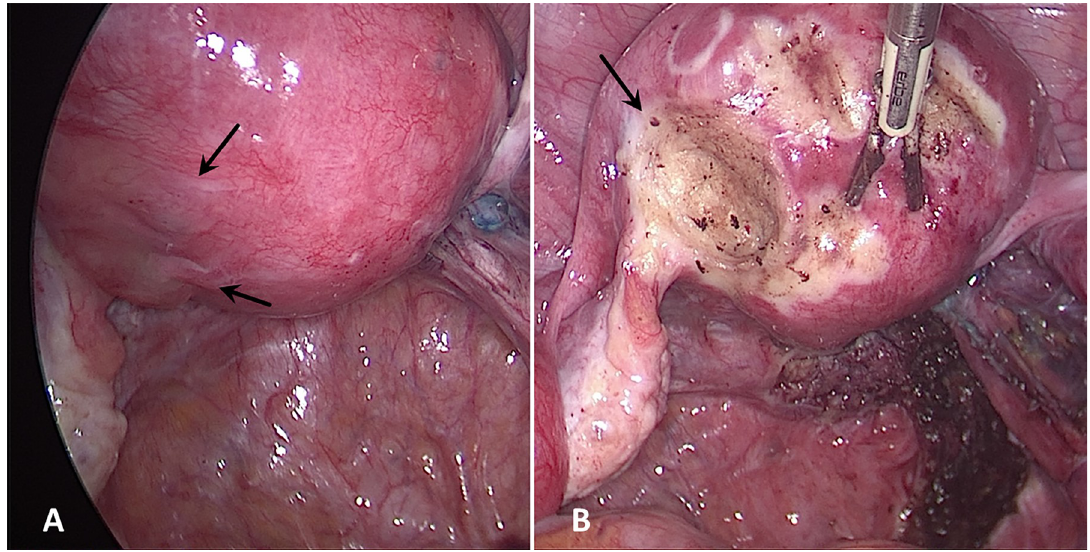
Fig 1. Laparoscopic images. A scattered blue area (arrow) after a dye test (A) that was biopsied (B).